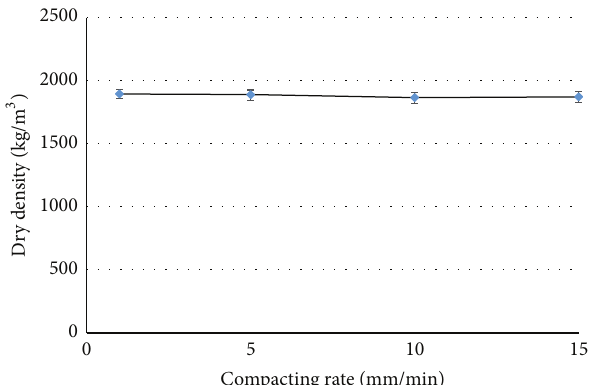
Figure 8: Compressive strength of compressed earth blocks (error bars represent range of data obtained) .